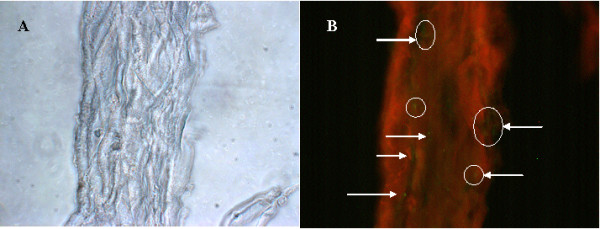
Detection of rMOMP expression by immunofluorescence staining in muscle tissue of vaccinated turkeys. The pictures show muscle tissue of vaccinated turkeys, at the site of injection, at 10 weeks p.v., viewed under a microscope under different light conditions (magnified 25 times). Picture 'A' shows the muscle cells under visible light. Picture 'B' shows the presence of green fluorescent rMOMP (by FITC-labelled antibodies, indicated on several places by white arrows) on a red background of muscle cells (Evans' Blue) under light of a wavelength of 488 nm.